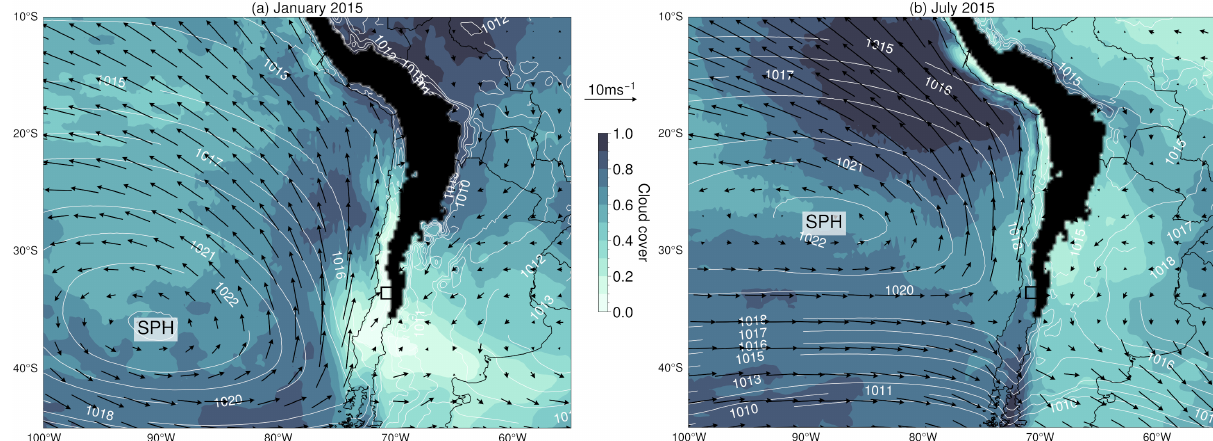
Figure 6. Synoptic-scale circulation for (a) January and (b) July 2015. Contours indicate mean sea-level pressure (hPa), the color map corresponds to cloud cover, and arrows show 10m wind speed. The black area represents the Andes where elevation is higher than 2500m. The black box indicates the location of Santiago. Data from ERA5 single-level reanalysis (Copernicus Climate Change Service,